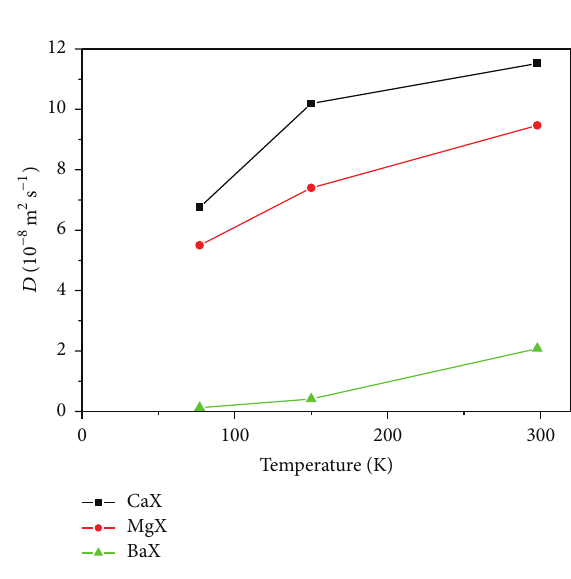
Figure6:Comparisonsoftheself-diffusioncoefficientsofhydrogen in three zeolites for loading 10